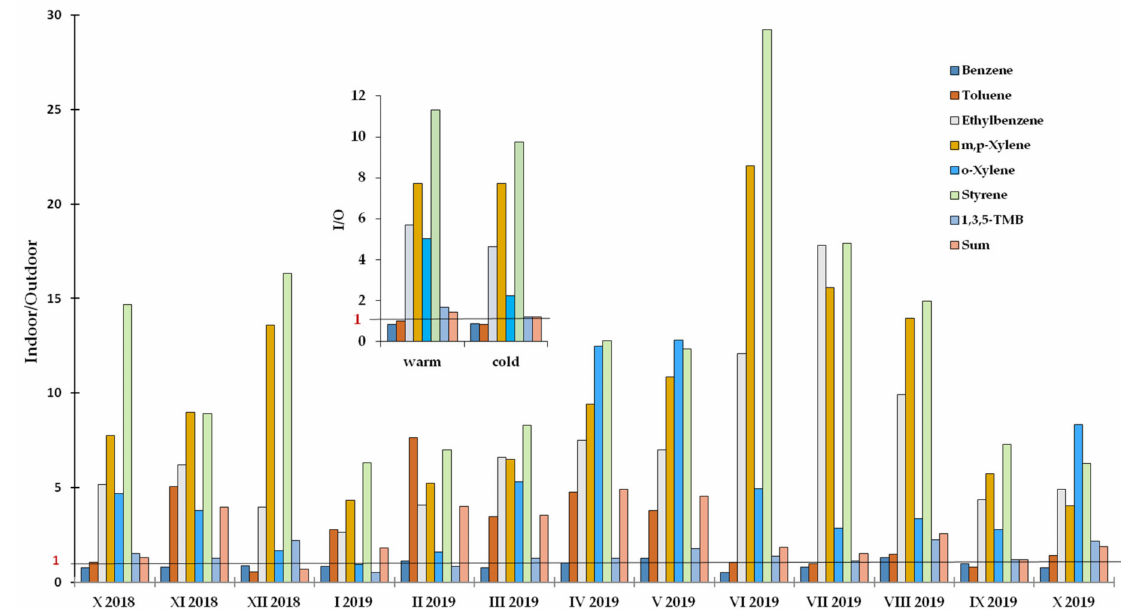
Figure 3. Indoor to outdoor ratios (I/O) of air pollutants.